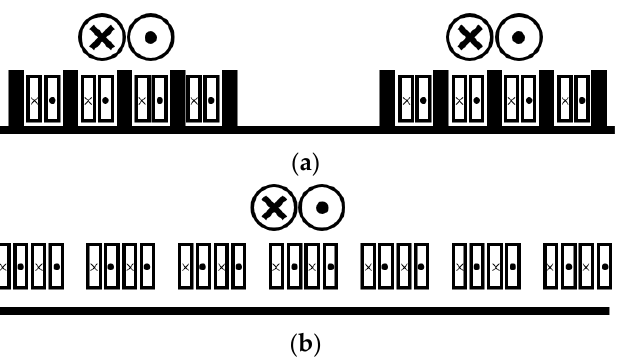
Figure 3. Cross section of the meander-type winding method. ( a ) Original model; ( b ) Bifilar method.